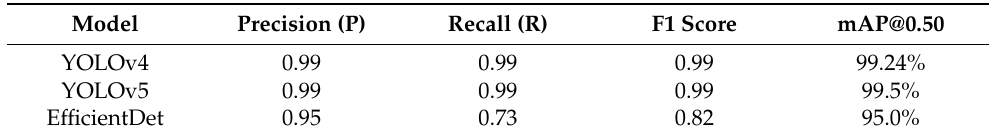
Table 5. Evaluation of object detection models for IoU